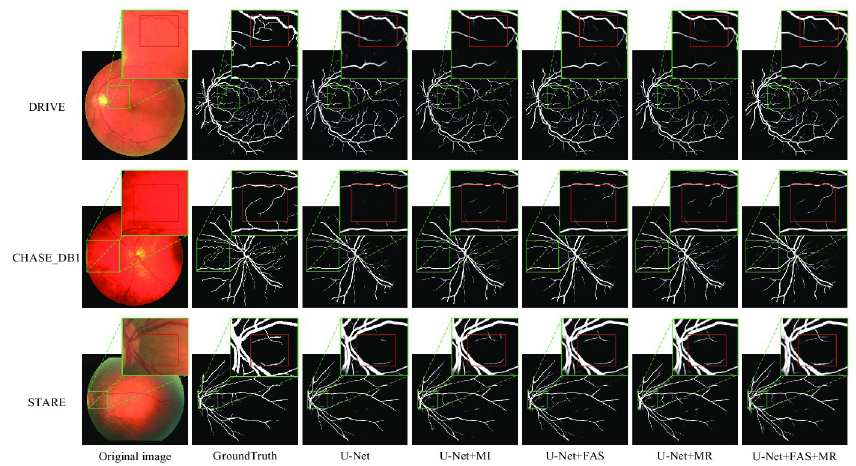
Fig 6. Segmentation result of ablation experiment. The areas that require special attention are zoomed in, and areas with obvious differences are marked with red rectangles.